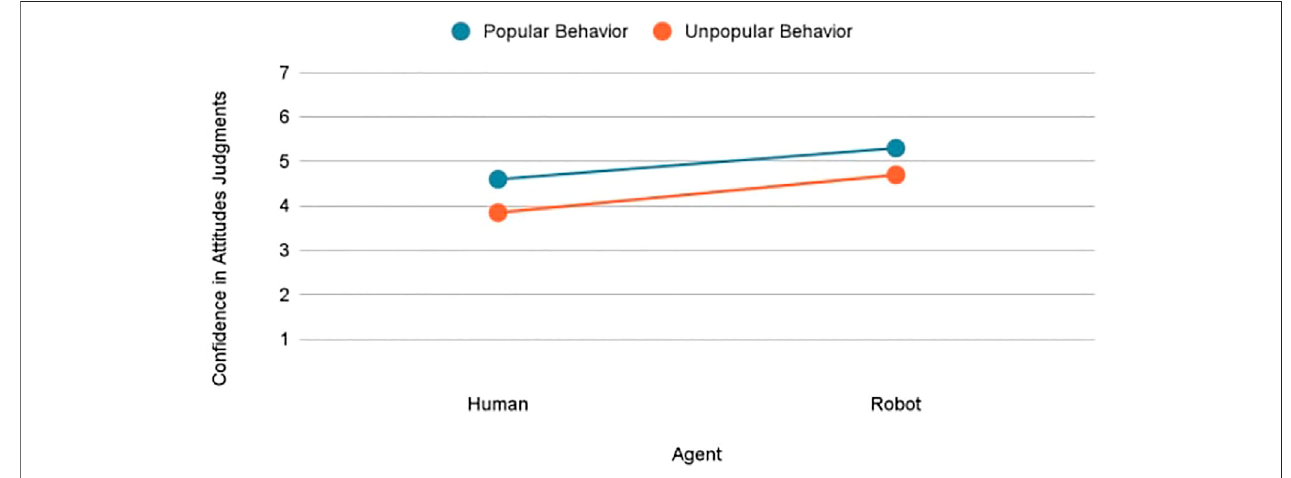
FIGURE 3 | Effects of agents and behavior on con fi dence in attitude attribution.